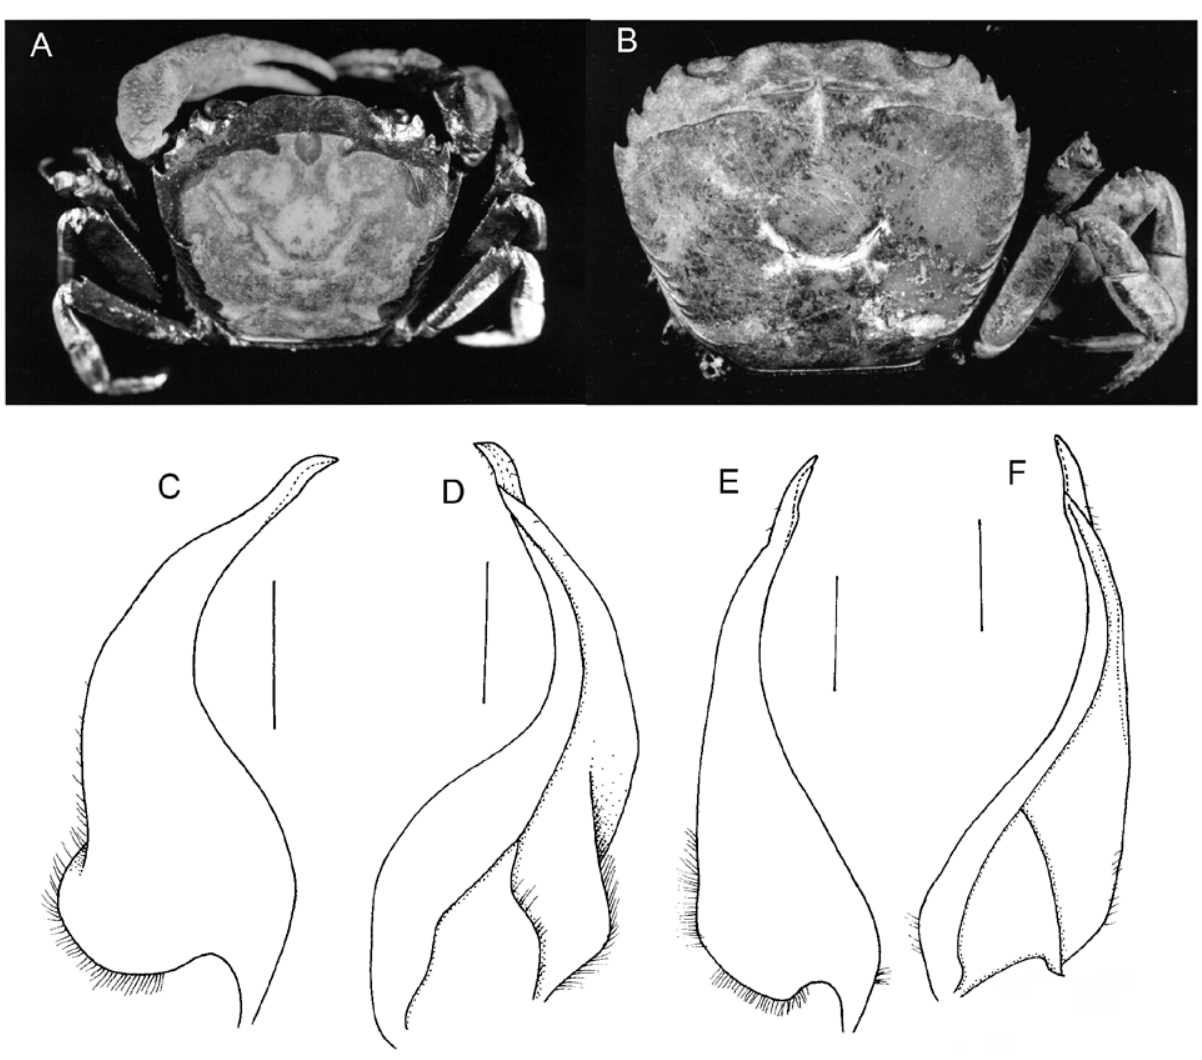
Figure 4. Mekhongthelphusa brandti (Bott, 1968), holotype male (21.8 × 17.8 mm) (SMF 4405) ( A, C, D ); Mekhongthelphusa neisi (Rathbun, 1902), lectotype male (22.6 × 18.5 mm) (MNHN-B 5311) ( B, E, F ). A, B , Dorsal view; C, E , G1 dorsal view; D, F , G1 ventral view. Scale bars = 1